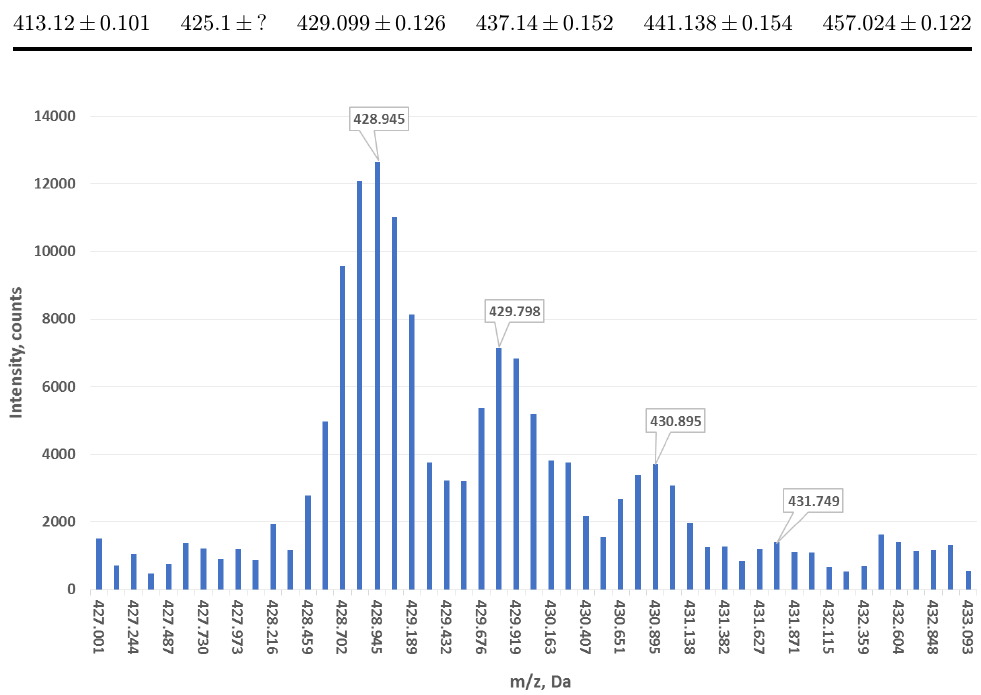
Fig. 8. The structured main line M = Z ¼ 428 : 945 Da in the MALDI spectrum of the urine fraction 8.5min elution accompanied by three equidistant satellites at 429.798, 430.895 and 431.748